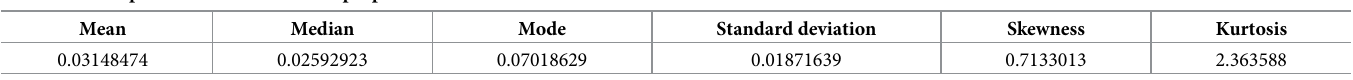
Standard error in parenthesis.